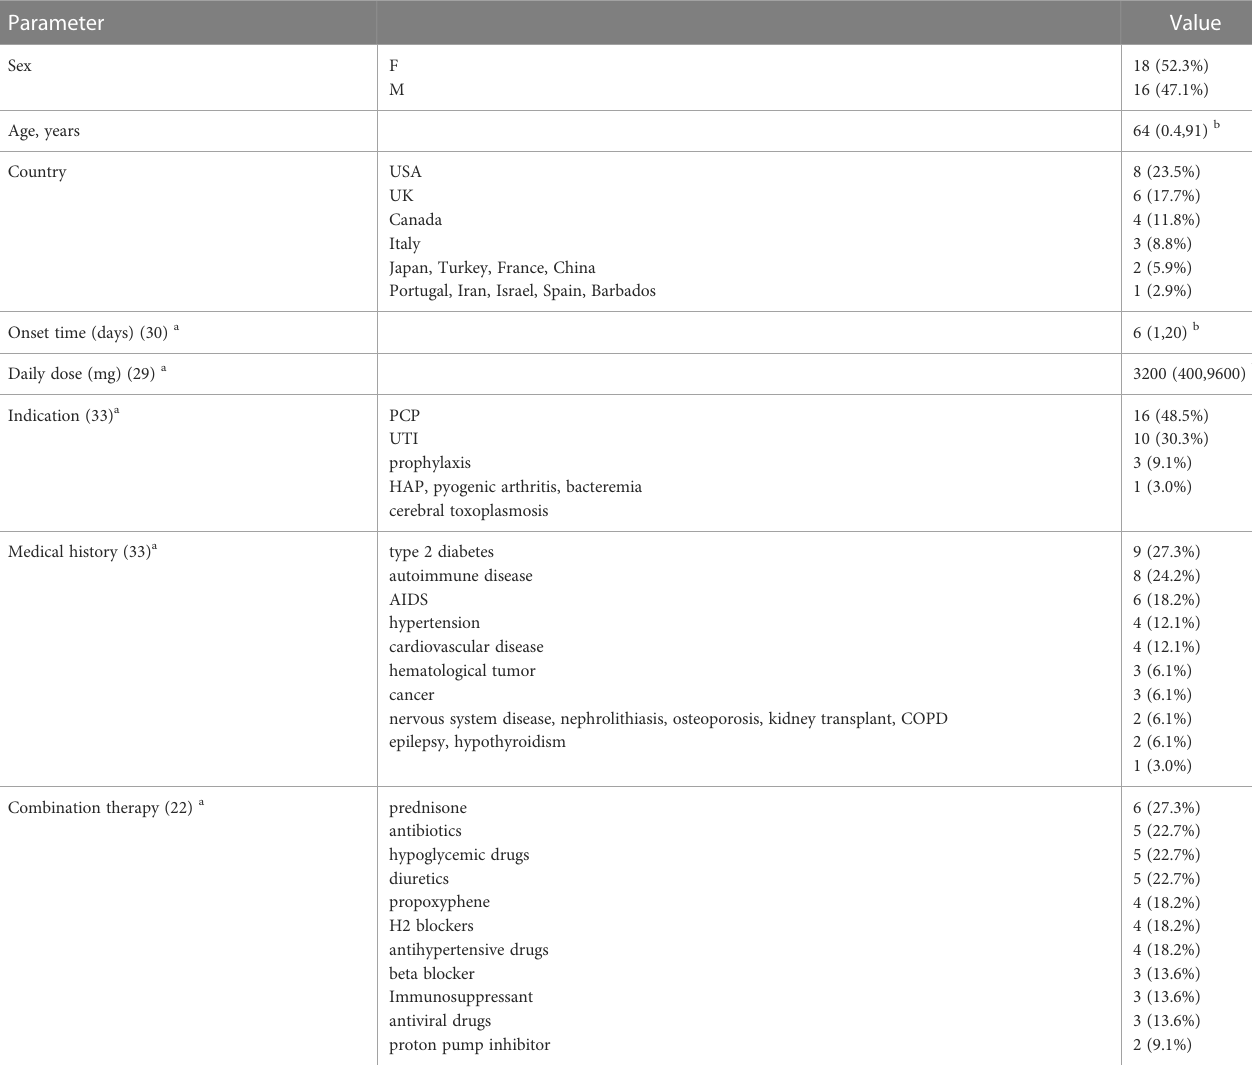
TABLE 2 Summary of basic information of 34 patients.